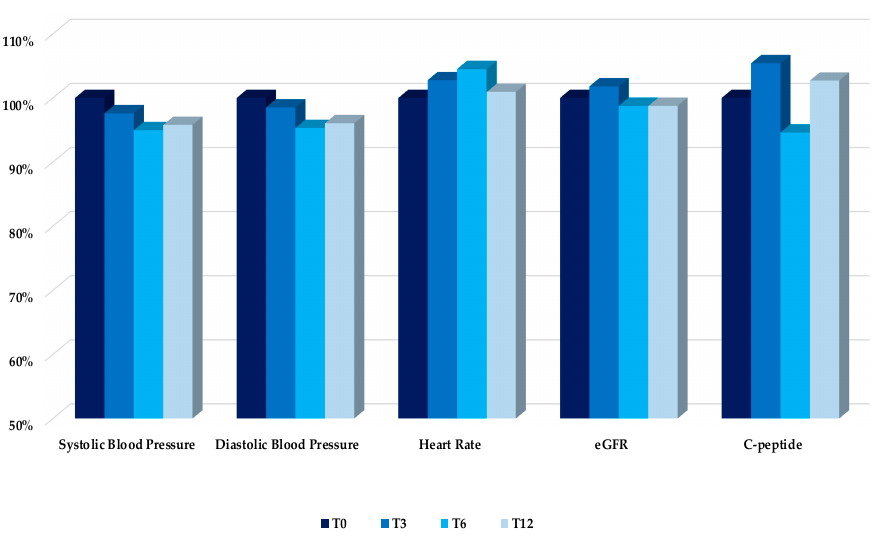
Figure 6. Mean changes, expressed as percentage changes from T0, in clinical parameters, eGFR, and serum C-peptide over the follow-up (T0, T3, T6, T12). No statistically significant changes have been found. Abbreviation: Glomerular filtration rate (eGFR).